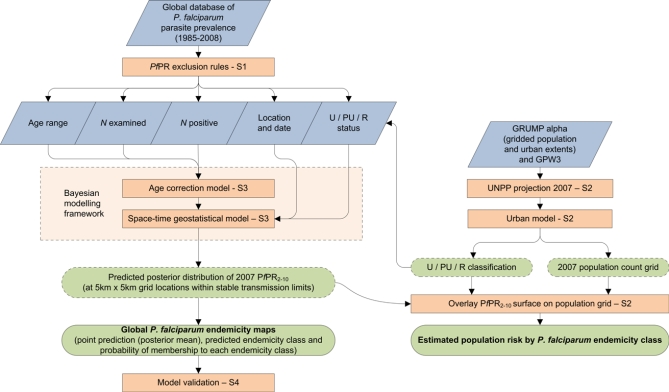
Schematic Overview of the Mapping Procedures and MethodsBlue diamonds describe input data. Orange boxes denote models and experimental procedures; S1, Protocol S1; S2, Protocol S2; S3, Protocol S3; and S4, Protocol S4. Green rods indicate output data; dashed lines intermediate output, solid lines final outputs. U, urban; PU, peri-urban; and R, rural extents.